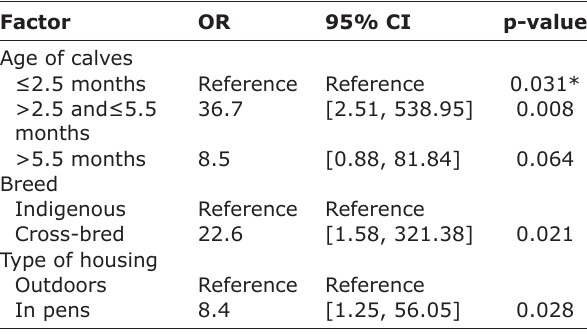
Table-3: Calf-level factors associated with leg dirtiness of 52 calves on 38 smallholder dairy farms in Kenya, 2017.